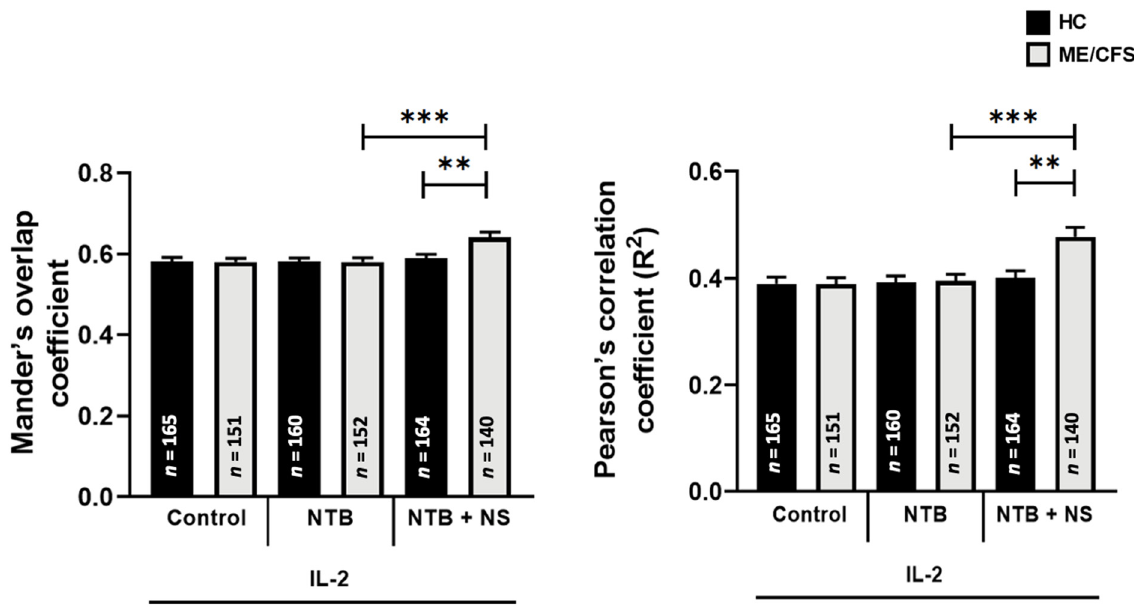
Figure 4. Co-localization of TRPM7 with actin in NK cells following IL-2 stimulation and treatment with NTB and NS8593 in HC vs. ME/CFS; n = 17 for HC and n = 17 for ME/CFS. The number of cells analyzed per condition are depicted on the bar graphs: n = 165 for HC Control, n = 151 for ME/CFS control, n = 160 for HC NTB, n = 152 for ME/CFS NTB, n = 164 for HC NTB + NS, n = 140 for ME/CFS NTB + NS. A significantly higher co-localization of TRPM7 with actin was identified in the ME/CFS cohort following NS8593 treatment compared with the ME/CFS NTB and HC NS8593 conditions. This difference was not present in the HC cohort. Data are represented as the mean ± SEM as determined by independent Mann-Whitney U tests. ** p < 0.01, *** p < 0.001. Abbreviations: healthy control (HC), myalgic encephalomyelitis/chronic fatigue syndrome (ME/CFS), natural killer (NK), NS8593 (NS), naltriben (NTB), transient receptor potential melastatin 7